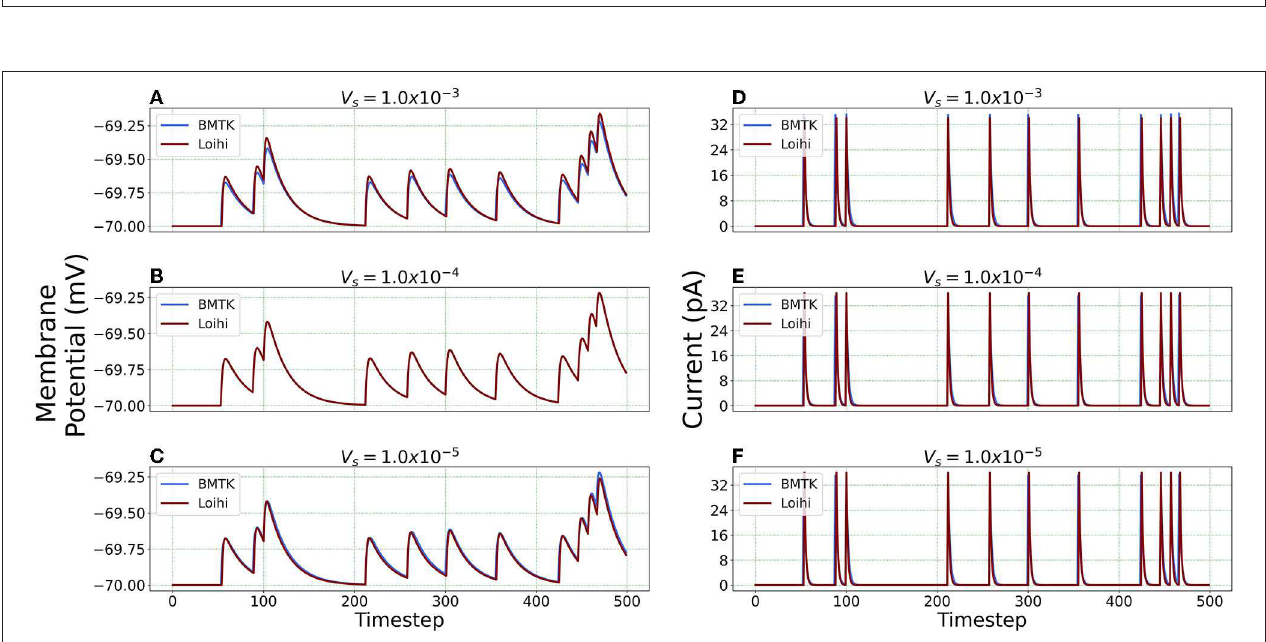
FIGURE 7 | Error comparison for different temporal precisions— (A) Membrane potential error. (B) Current error. In both panels, the RMSE for the corresponding state is plotted against the log of the temporal precision dt .